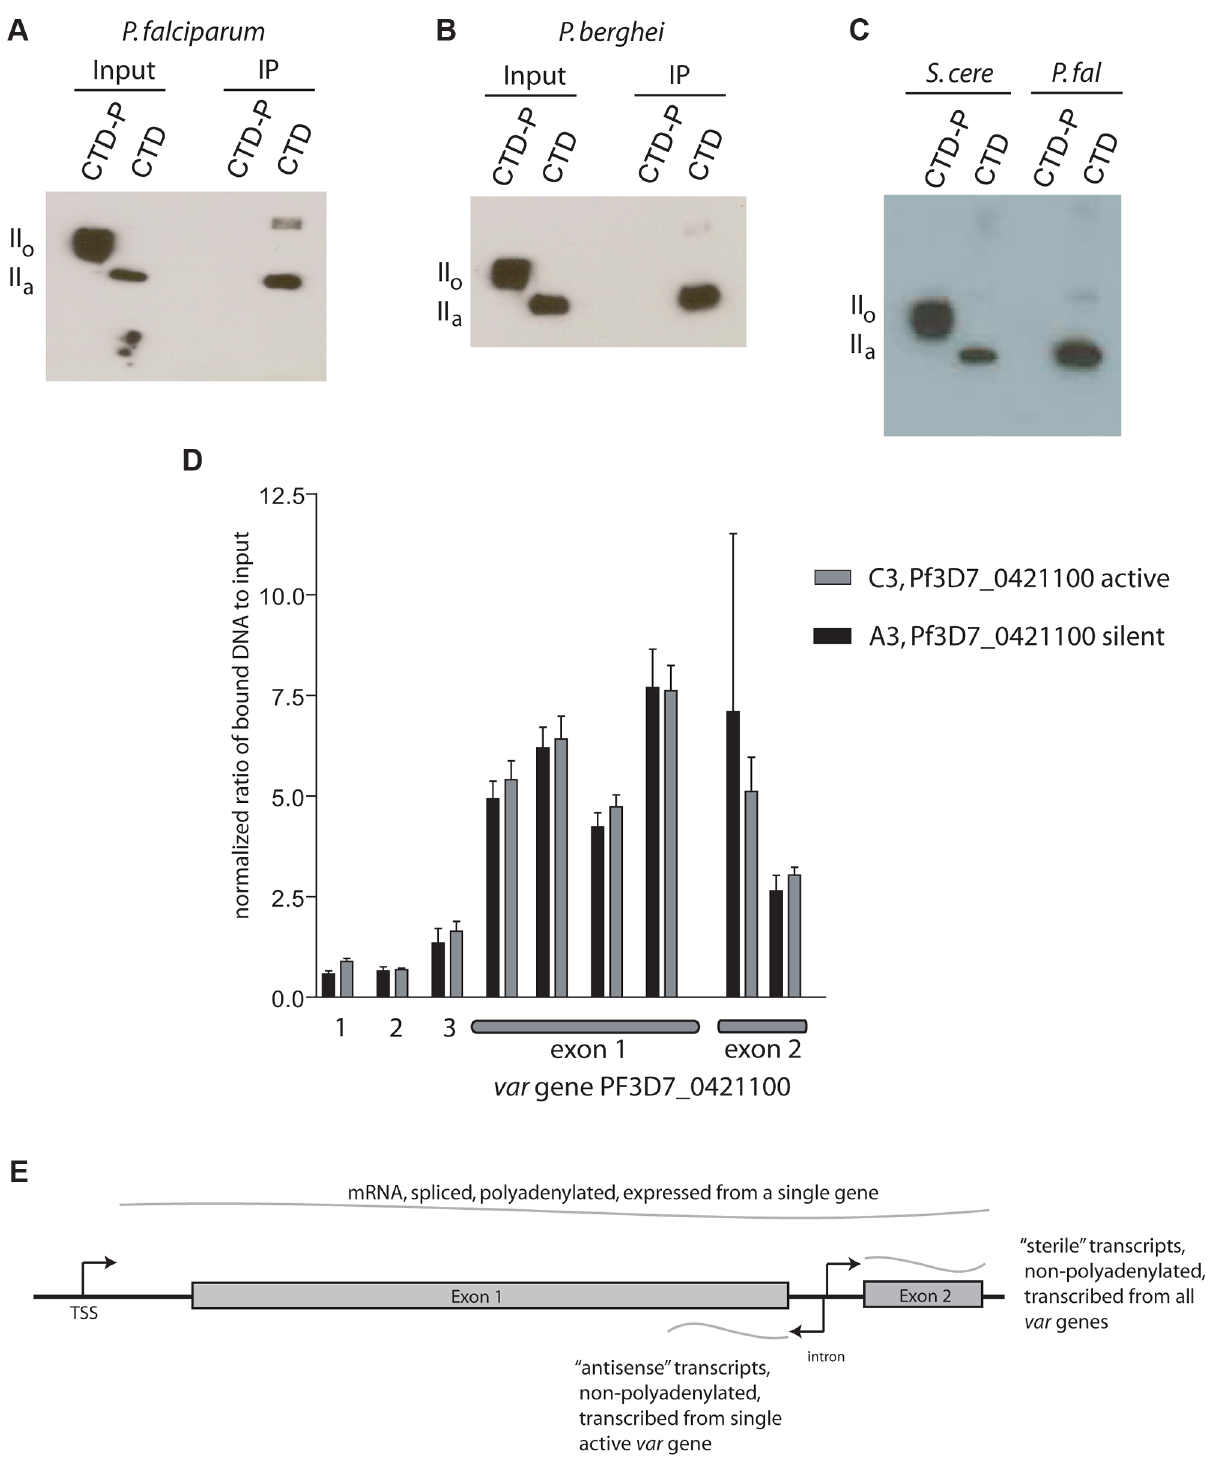
Figure 3. Phosphorylation dependence of PfSET2 binding to the CTD and enrichment of H3K36me3 at var loci. (A) Co- immunoprecipitation assays showing that phosphorylation of the CTD of Rpb1 eliminates binding by PfSET2. The two left lanes show the flag-tagged P. falciparum Rpb1 in its phosphorylated (II o ) or unphosphorylated (II a ) states. The right two lanes show blots of co-immunoprecipitation assays after incubation of bacterial lysates containing the HA tagged, N-terminal region of PfSET2 (PfSET2 1–359 ) with phosphorylated and unphosphorylated CTD. Phosphorylation of the CTD disrupts binding by PfSET2. (B) Co-immunoprecipitation assays as in A performed with the CTD of Rpb1 from P. berghei . (C) Direct comparison of the CTD binding affinities of SET2 from S. cerevisiae and P. falciparum. The SRI from S. cerevisiae (left two lanes) interacts preferentially with the phosphorylated form of the P. falciparum CTD (left) but also displays lesser binding to the unphosphorylated form (right). The right two lanes show the same assay with the P. falciparum SRIR region (amino acids 1–359). The SRIR displays specific binding to the unphosphorylated CTD (right) and little or no binding to the phosphorylated form (left).(D) Chromatin immunoprecipitation assays from ring stage